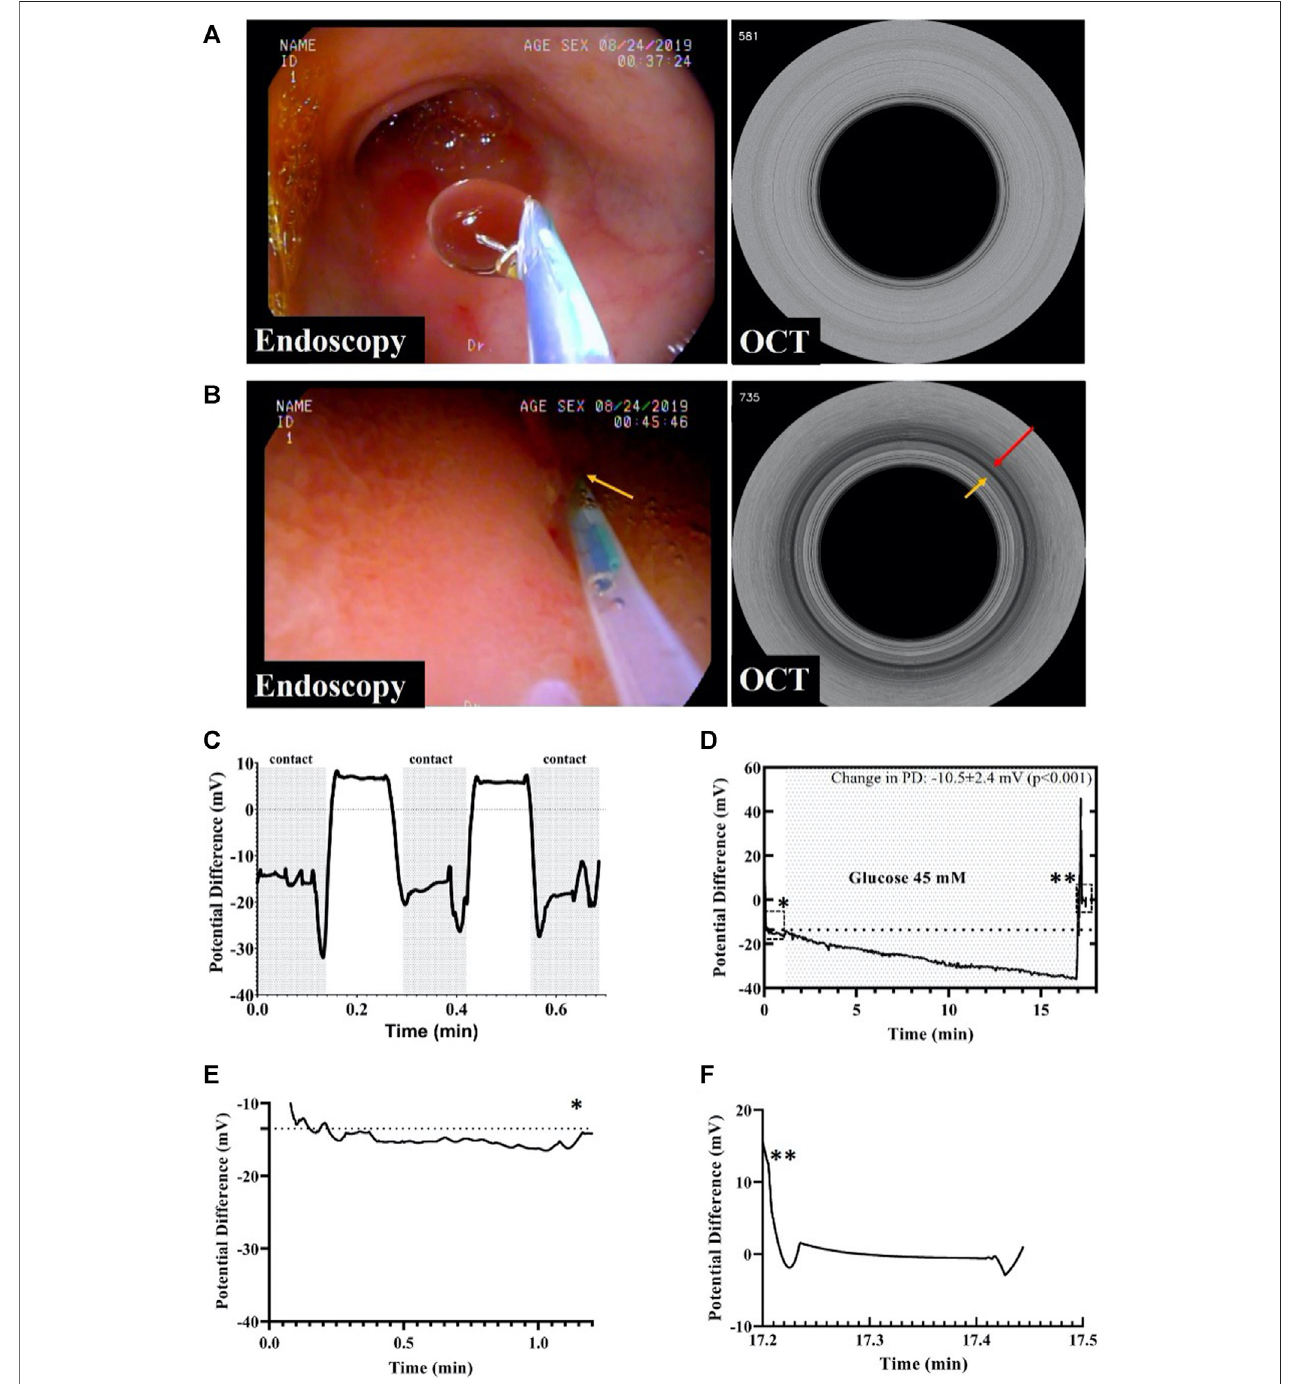
FIGURE 3 | (A) Endoscopic image of the duodenum showing the GPD probe not in contact with the mucosa and the corresponding M-mode OCT image. (B) Endoscopic image showing the IPD probe in contact with the mucosa. An M-mode OCT frame corresponding to the endoscopy frame depicting the GPD probe in contact with the duodenal mucosa, as shown by the dark ring pointed by the red arrow. (C) GPD values measured by the probe in contact and not in contact with the mucosa. (D) This fi gure shows a change in the gut potential difference after glucose perfusion. The baseline GPD value changed in presence of 45 mM glucose solution by as much as − 10.5 mV. The single asterisk demarcates the region enclosed by the dashed rectangle before glucose infusion while the double asterisks point to theregion inthe rectangle depictingthe potential differenceacrossthe probeand the reference skin patch after theprobe wasretractedfrom thebody. (E) The graph shows baseline GPD value of the duodenum before infusion of glucose. (F) After probe retraction from the duodenum, the graph shows the GPD between the GPD probe and the skin patch was about zero, indicating that the change in GPD prior to retraction was solely due to the presence of glucose, and not because of a walk-off between the probe and the reference skin patch. The asterisks indicate the positions of the graphs in (E) and (F) in the original graph in (D) .